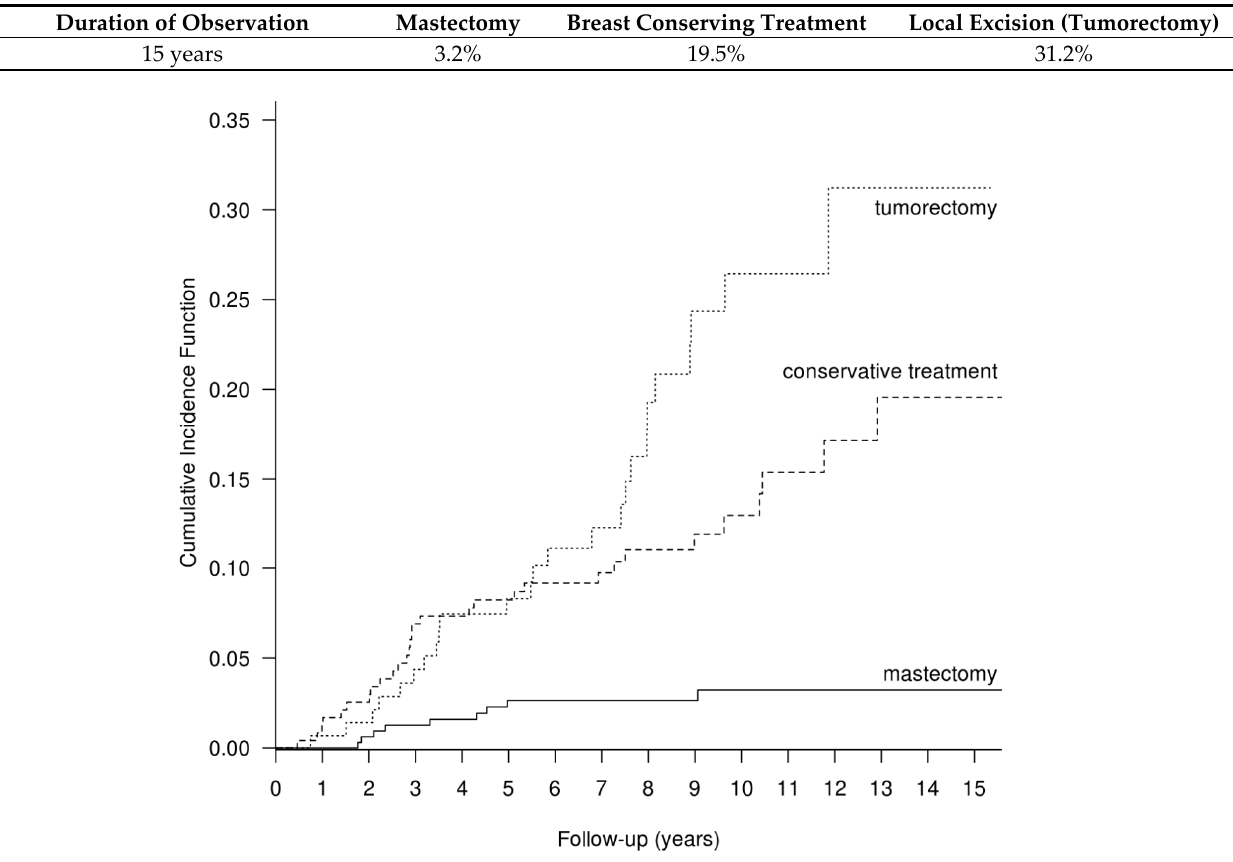
Figure 1. Cumulative recurrence risk after mastectomy, BCT and BCS in the group of 737 DCIS patients, calculated with the method of competitive hazards; p < 0.001.